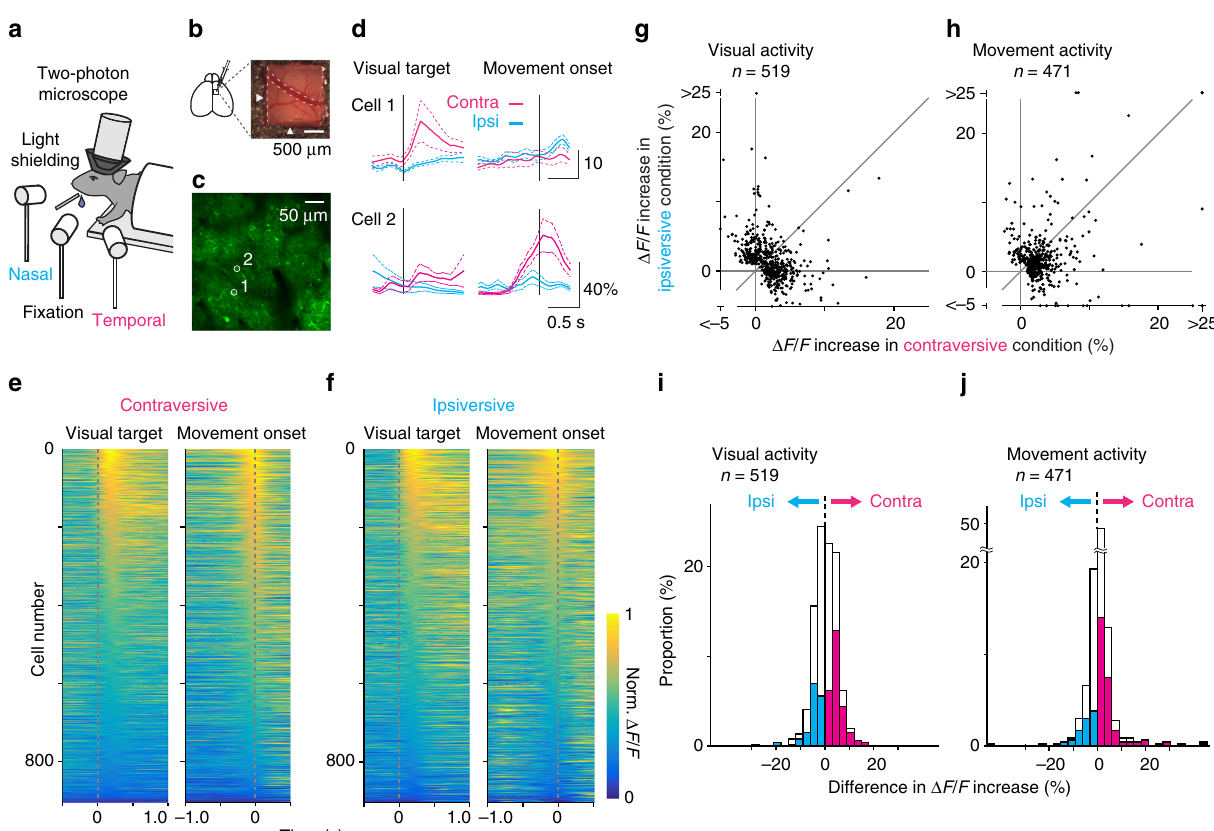
Fig. 3 Neural coding in the MO s . a The experimental design. b Cranial window for two-photon imaging. Arrowheads indicate 700 µ m rostral and 700 µ m lateral from the bregma. Note a bridging vein leading to the superior sagittal sinus, which often runs around the coordinates. c Virally expressed GCaMP6f in the MO s for two-photon calcium imaging during the visually guided eye movement task. d Averaged fl uorescence change of two example cells (ROIs shown in c , aligned to the onset of the visual target or to the onset of the eye movement; cyan, the trial condition for ipsiversive eye movement; magenta, for contraversive). e , f Sorted normalized Δ F / F traces for 904 neurons showing signi fi cant response either to visual targets or to eye movements. Response was aligned to the onset of the visual target or the movement in the contraversive ( e ) or ipsiversive ( f ) trials. g – j Comparison between contraversive and ipsiversive movement trials for visual and motor activity ( n = 519 or 471 neurons, showing signi fi cant visual or motor activity). i , j A histogram for difference between ipsiversive and contraversive conditions in visual or motor activity. Neurons with a larger response in the contraversive condition ( p < 0.05, Mann – Whitney test) were labeled as magenta ( n = 135 in visual activity, 122 in motor activity) and neurons with a larger response in the ipsiversive condition in cyan ( n = 80, 45). The population preferred for the contraversive condition in visual activity ( n = 519, p < 0.05, Wilcoxon signed-rank test) and in motor activity ( n = 471, p < 10 − 12